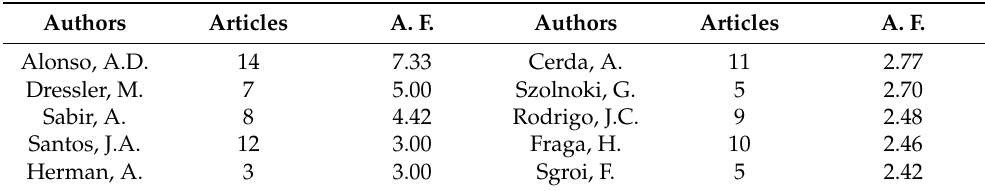
Table 4. Classification of leading authors considering the number of published articles fractioned according to the number of authors.